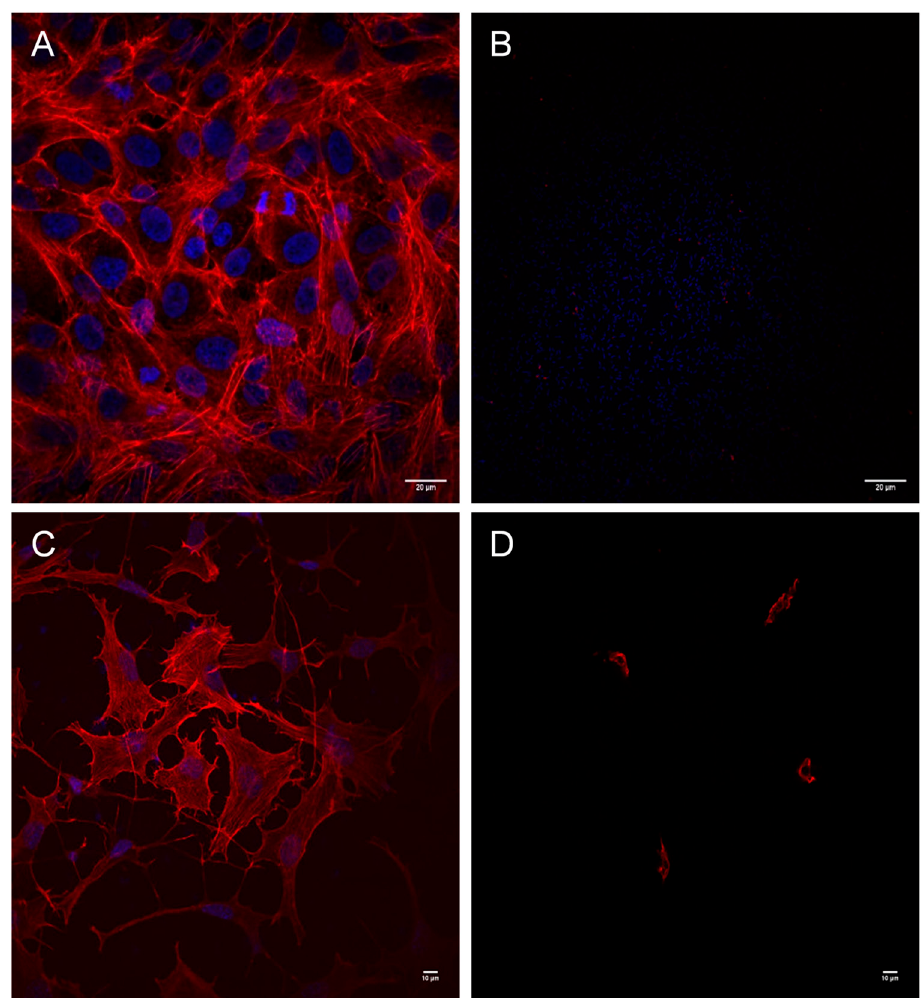
Figure 2. Aeromonas strains trigger a cytotoxic effect during infection of Vero cells and mouse fibroblasts. Infection was carried out in Vero cells with strains LE20E ( A ) and AG29E1 ( B ), and in mouse fibroblasts with non-cytotoxic strain AG26E ( C ), and cytotoxic strain AG29E1 ( D ) for 180 min. Cells were fixed and stained for immunofluorescence. The actin cytoskeleton was labeled with Atto 594 phalloidin (red), and the nuclei stained with DAPI (blue). Results are representative of at least three independent experiments. Micrographs were originally captured at ×400 magnification. Bars indicate 20 µm ( A , B ), or 10 µm ( C , D ).